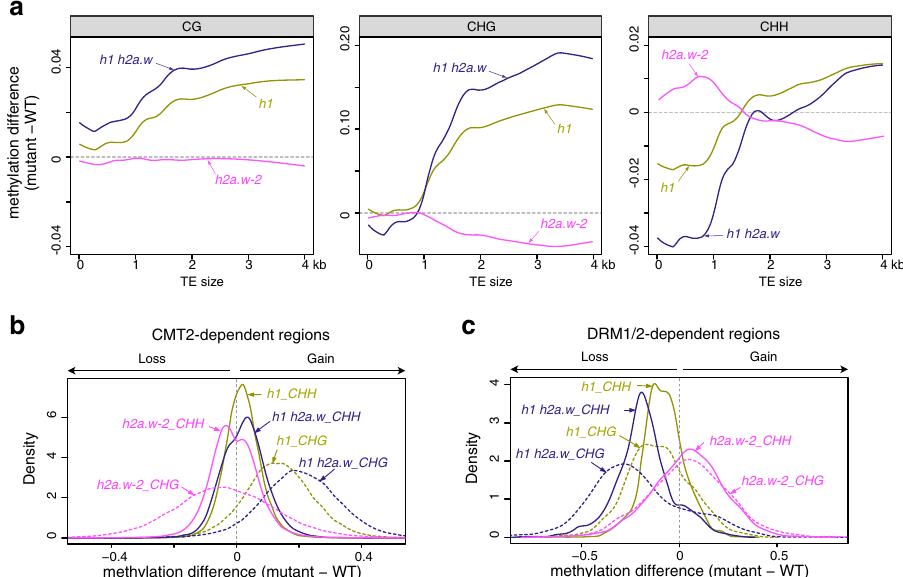
Fig. 7 Impact of combined loss of H2A.W and H1 on DNA methylation. a Locally weighted scatterplot smoothing (LOESS) fi t of changes in CG, CHG, and CHH DNA methylation in h2a.w-2 , h1 and h1 h2a.w mutants (mutant minus WT) in 50 bp windows plotted against TE size. b Kernel density plots of CHG and CHH DNA methylation changes at CMT2-dependent regions in h2a.w-2 , h1 and h1 h2a.w mutants. c Kernel density plots of CHG and CHH DNA methylation changes at DRM1/2-dependent regions in h2a.w-2 , h1 and h1 h2a.w